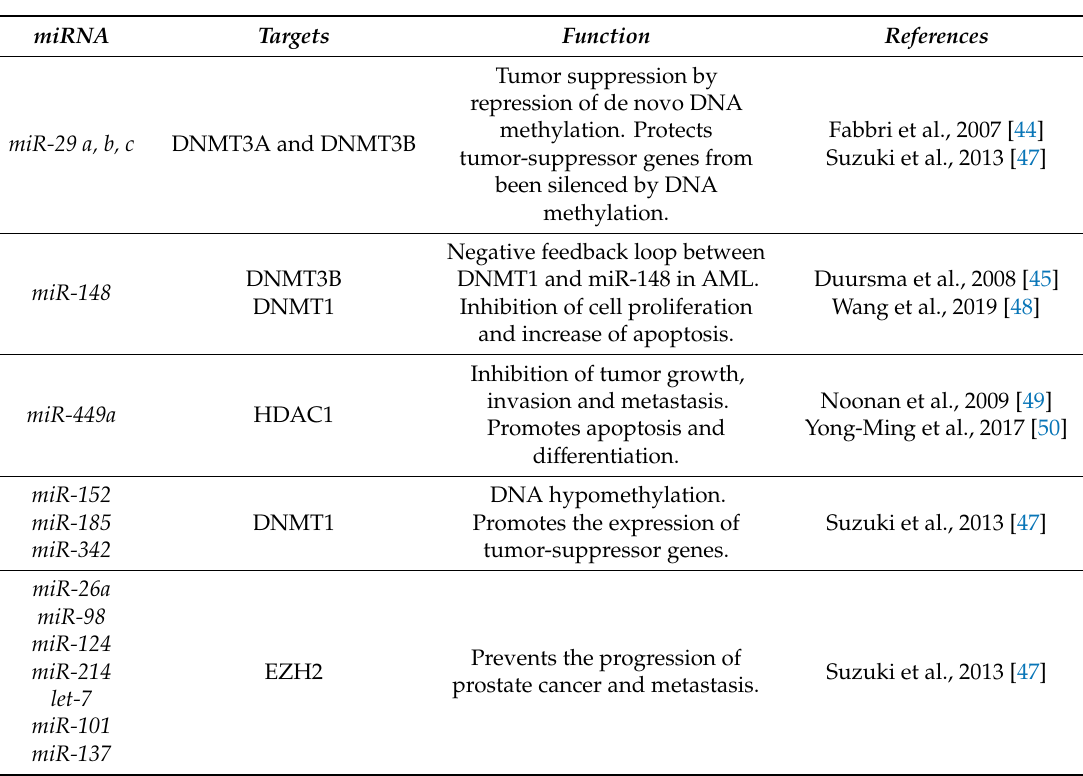
Table 1. MicroRNAs (MiRNAs) targeting epigenetic regulators. DNMT1: DNA-methyl transferase 1 and AML: acute myeloid